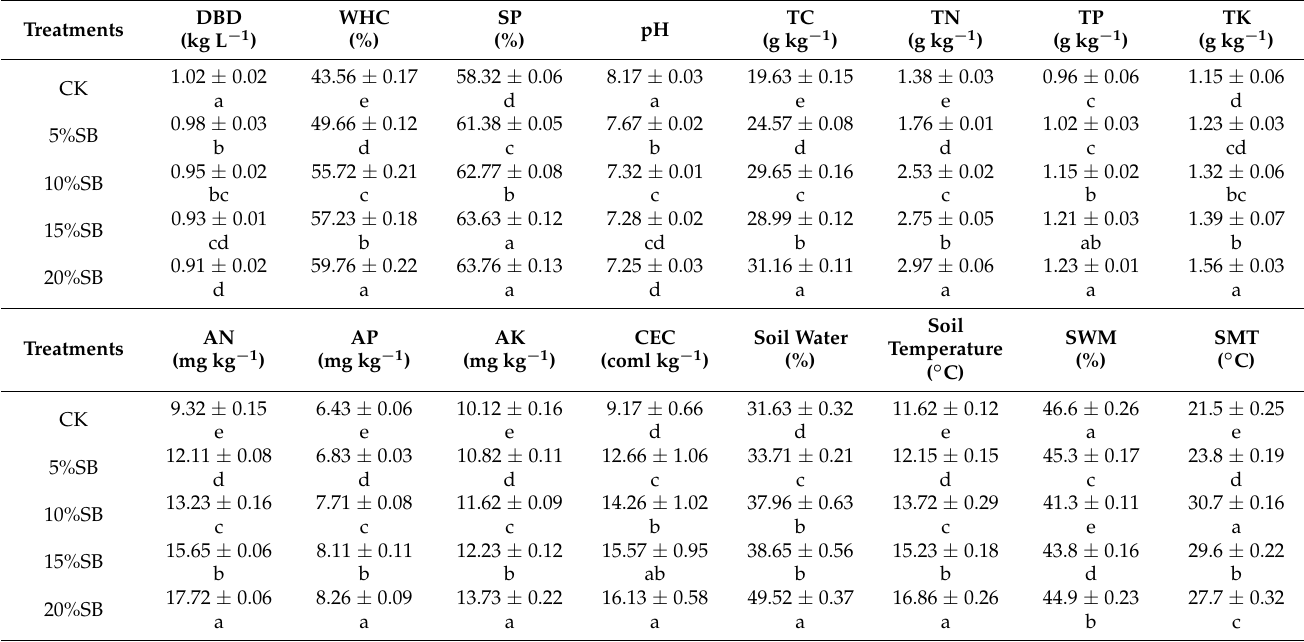
Figure 1. The scanning electron microscopy of the biochar (5 µ m and 10 µ m). Table 2. The physicochemical properties of the green roof soil.